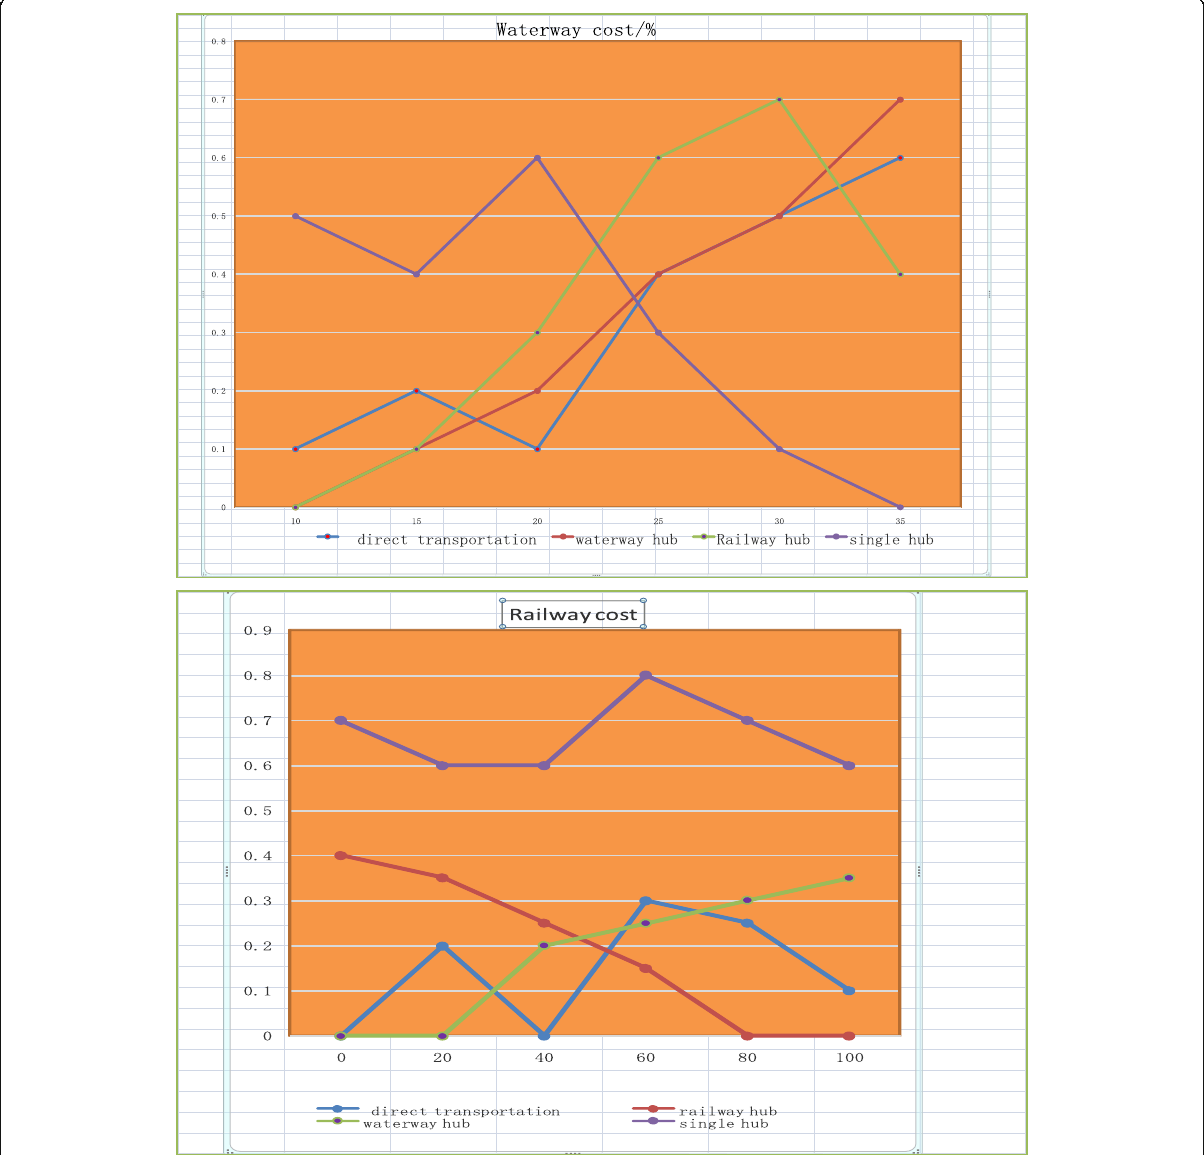
Fig. 3 Sensitivity analysis of container transport mode share ratio. Container railway and waterway combined transport promotes the collaborative operation among waterway, railway and highway modes in conscious and unconscious